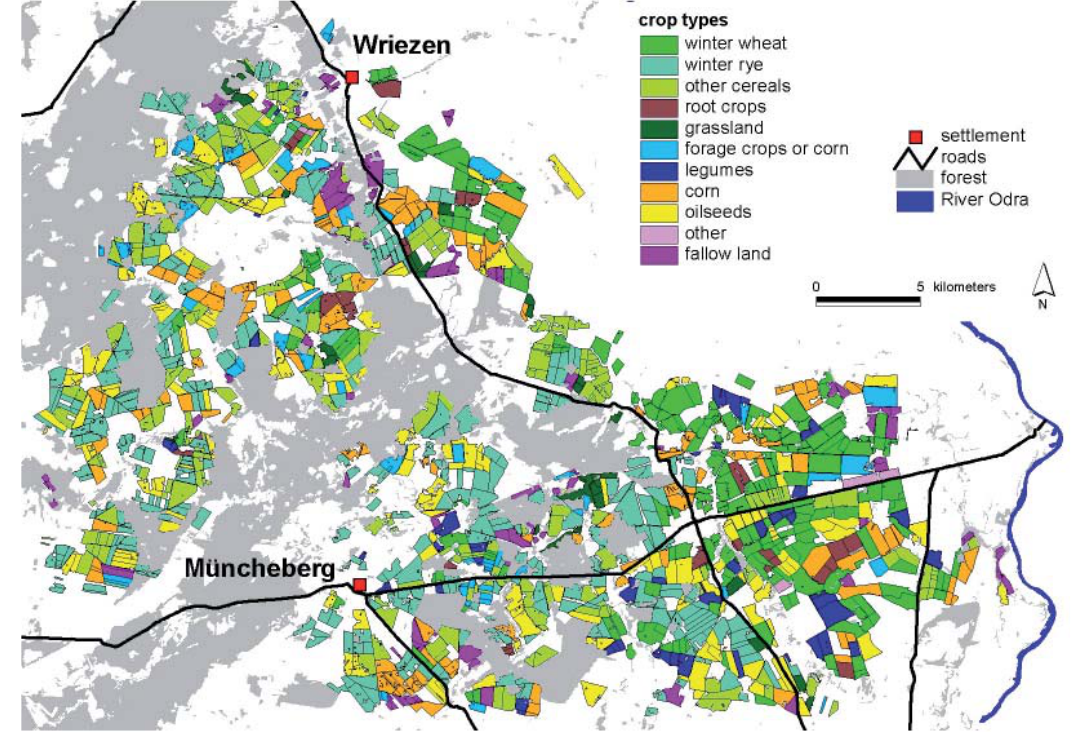
Figure 2. Investigated plots within the research area showing the distribution of crops for the Initial Situation 2000.